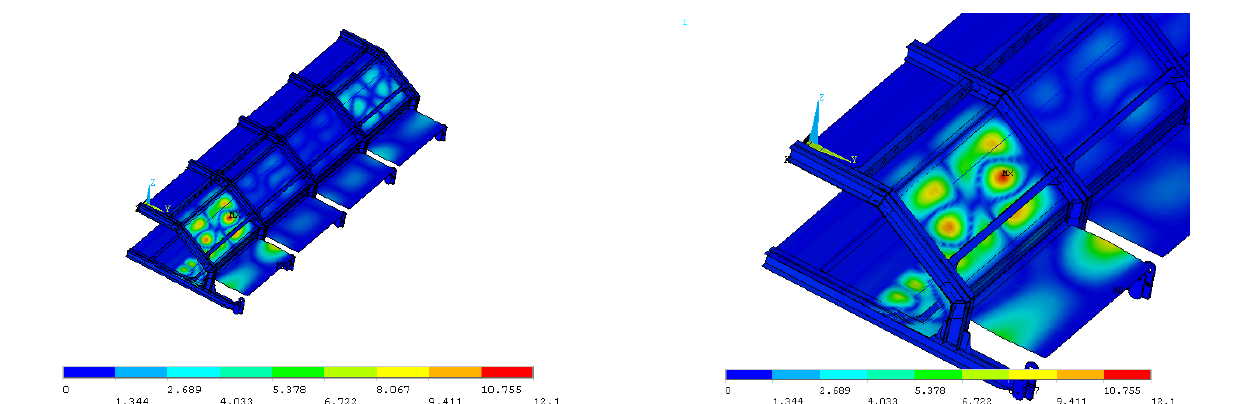
Figure 14: Buckling mode shape for the first eigenvalue. Figure 15: Buckling mode shape for the first eigenvalue (detailed